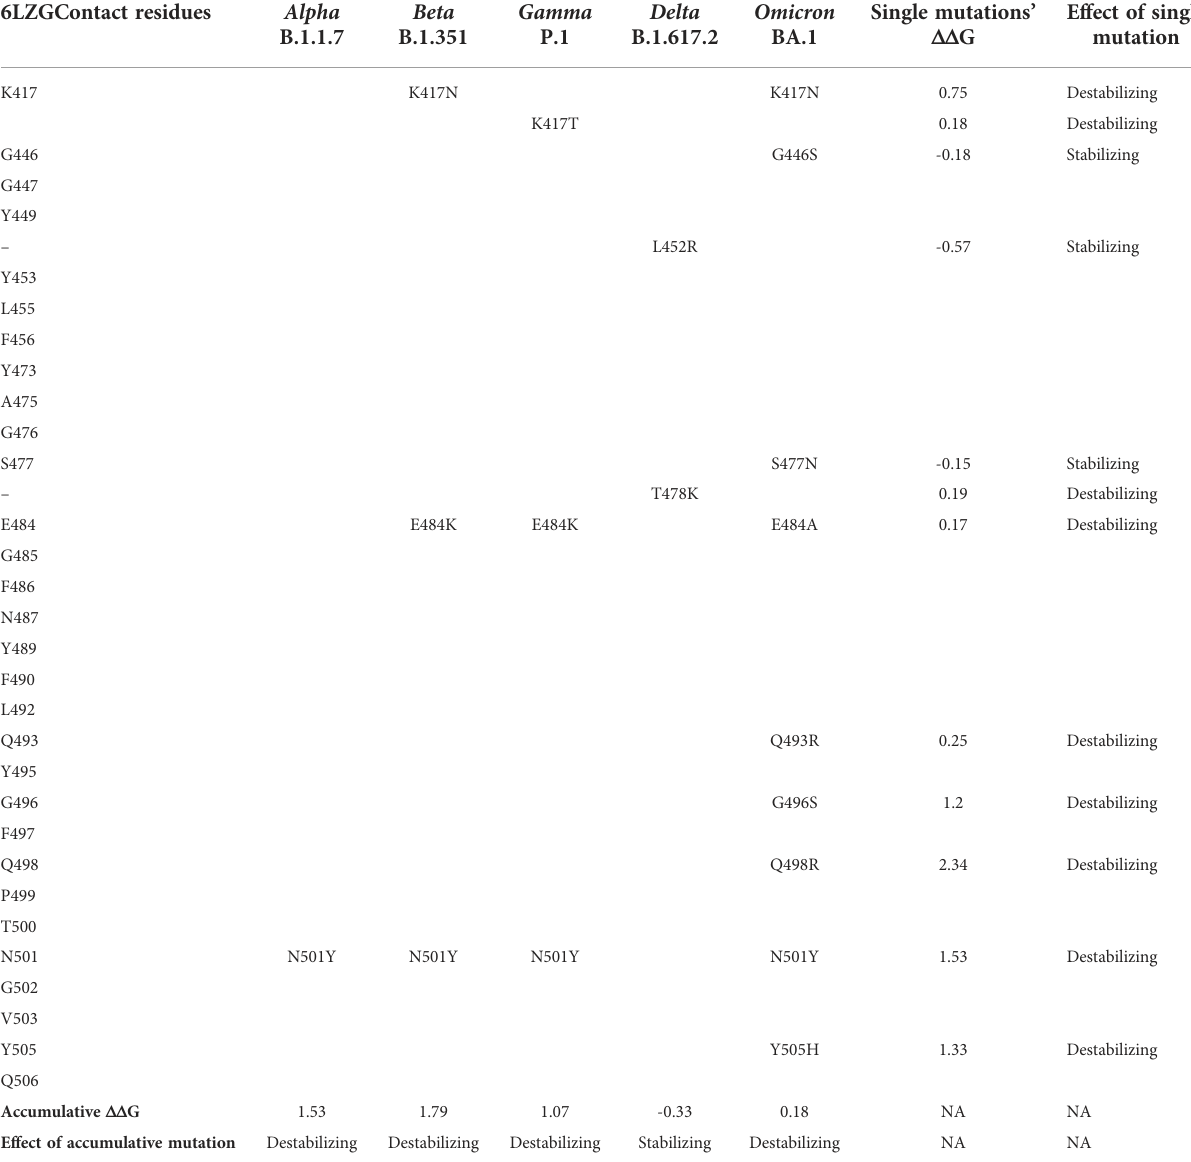
TABLE 4 Comparison of the mutation pro fi les of fi ve SARS-CoV-2 VOCs ’ S protein in the contact residues with the ACE2 receptor. 6LZGContact